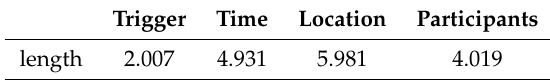
Table 5. Average length of Chinese event